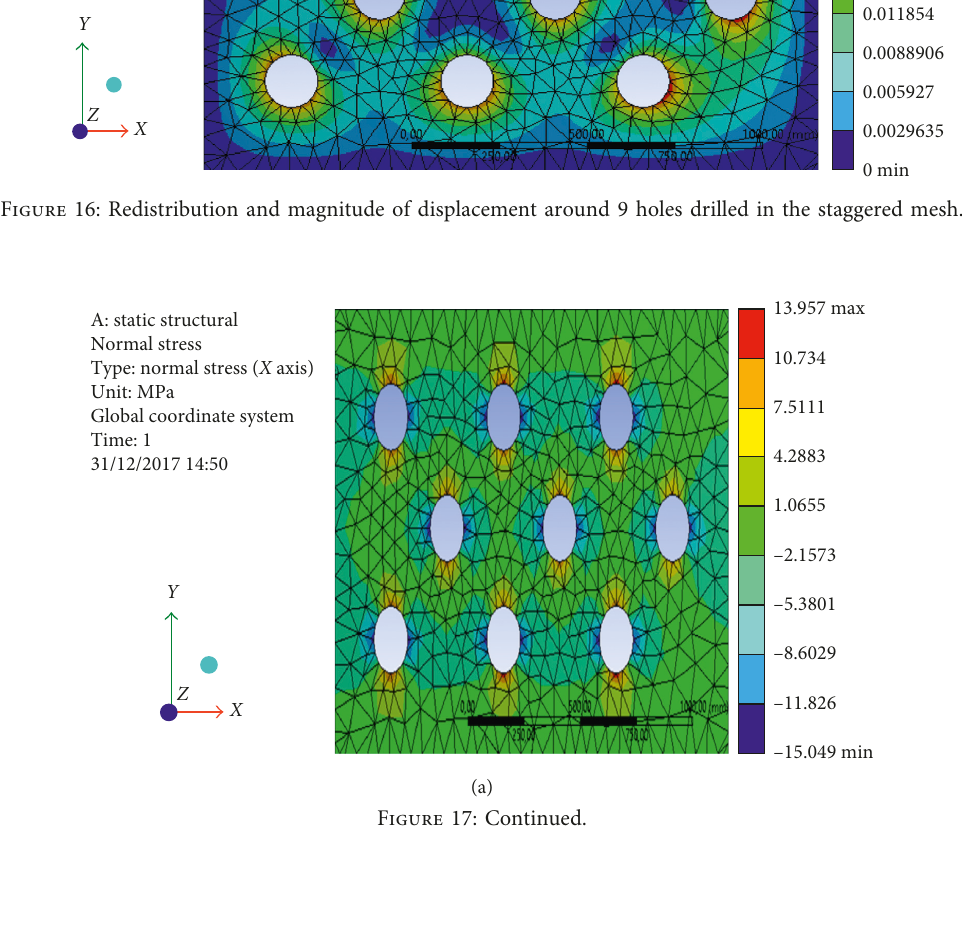
A: static structural Total deformation